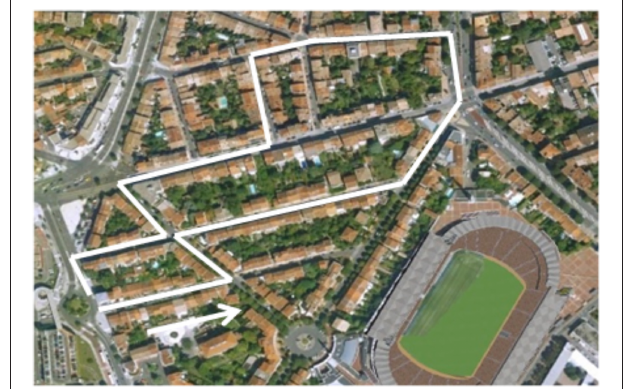
FIGURE 2 | The route learned by the participants. Adapted from Taillade et al. (2013,